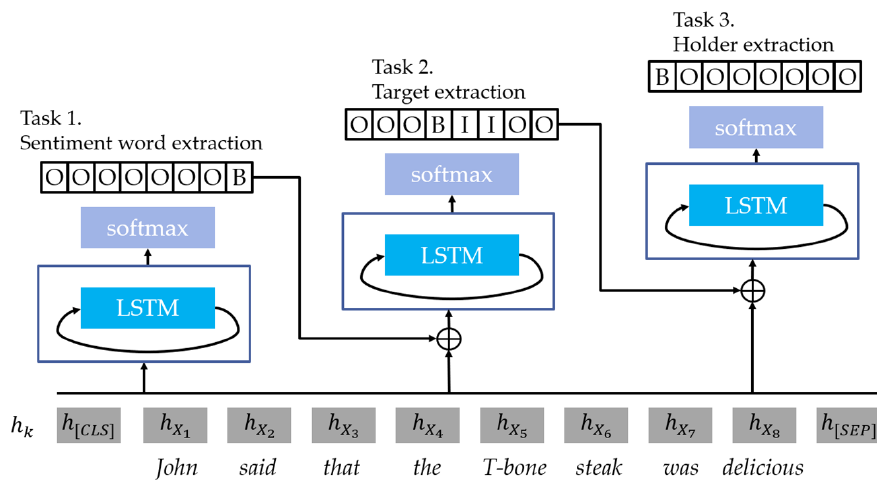
Figure 12. The framework of task-specific layer.